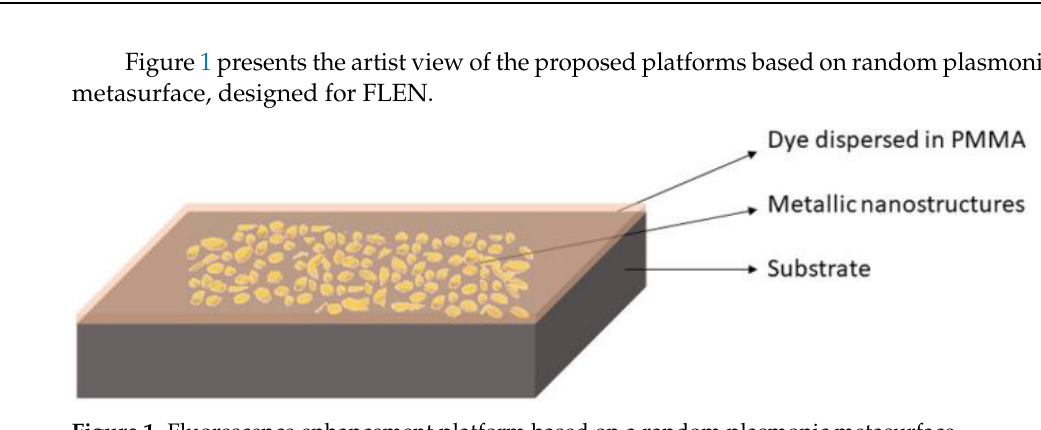
Figure 1. Fluorescence enhancement platform based on a random plasmonic metasurface.